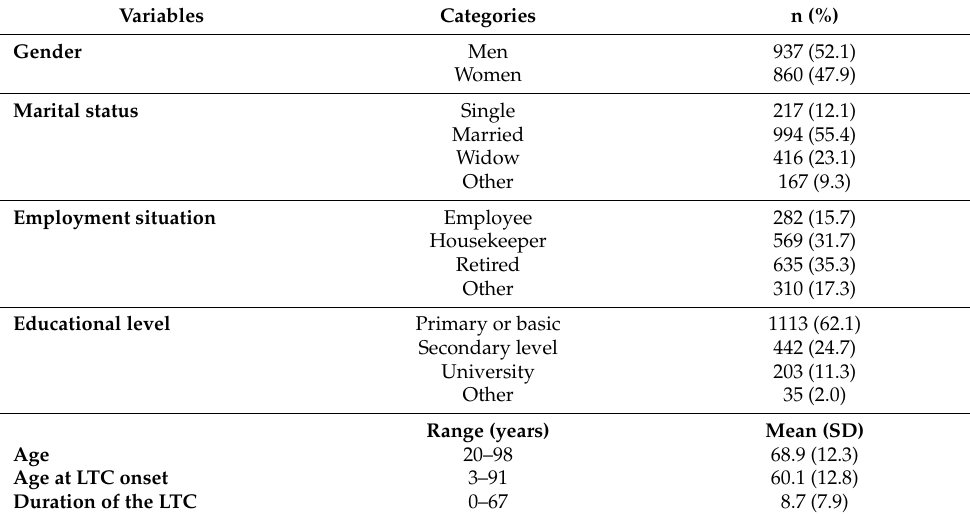
Table 2. Sociodemographic and disease characteristics of the total